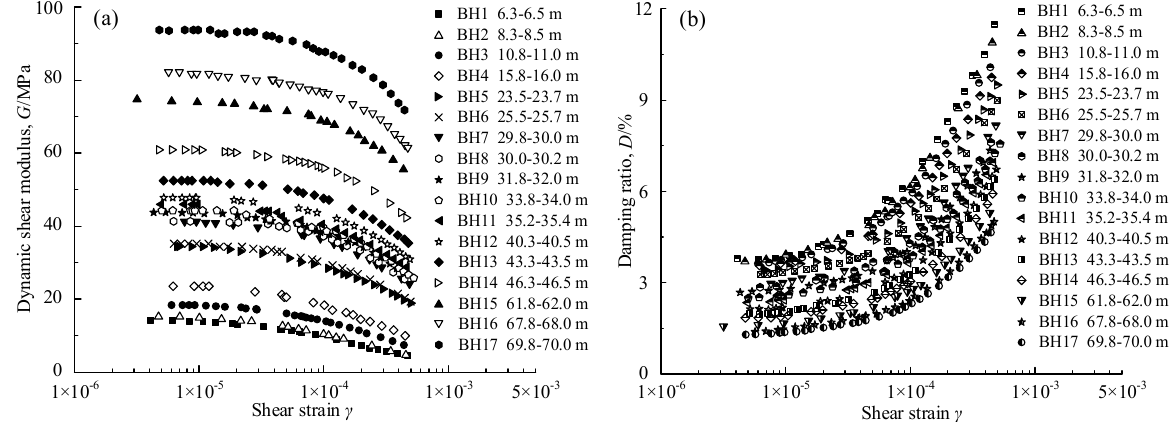
Figure 3. Experimental results of RC tests on marine clay from Bohai Bay: ( a ) variation of dynamic shear modulus with shear strain; ( b ) variation of damping ratio with shear strain.